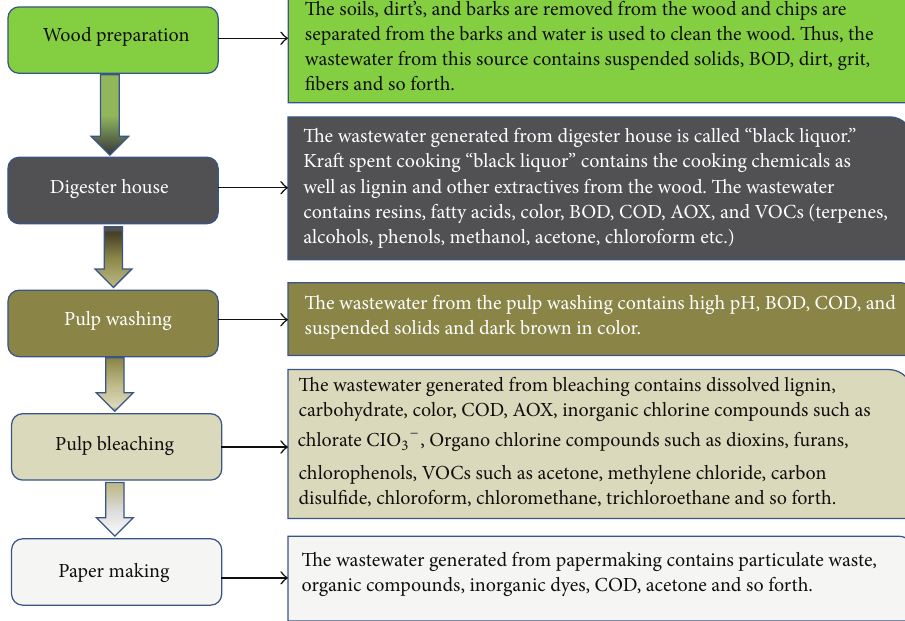
Figure 2: Pollutants produced in different stages of paper industry. (Figure 2 is reproduced from reference [23]. Copyright 2004, with permission from Elsevier). Table 1: Typical characteristics of wastewater at different pulp and paper processes. (Table 1 is reproduced from [23]. Copyright 2004, with permission from